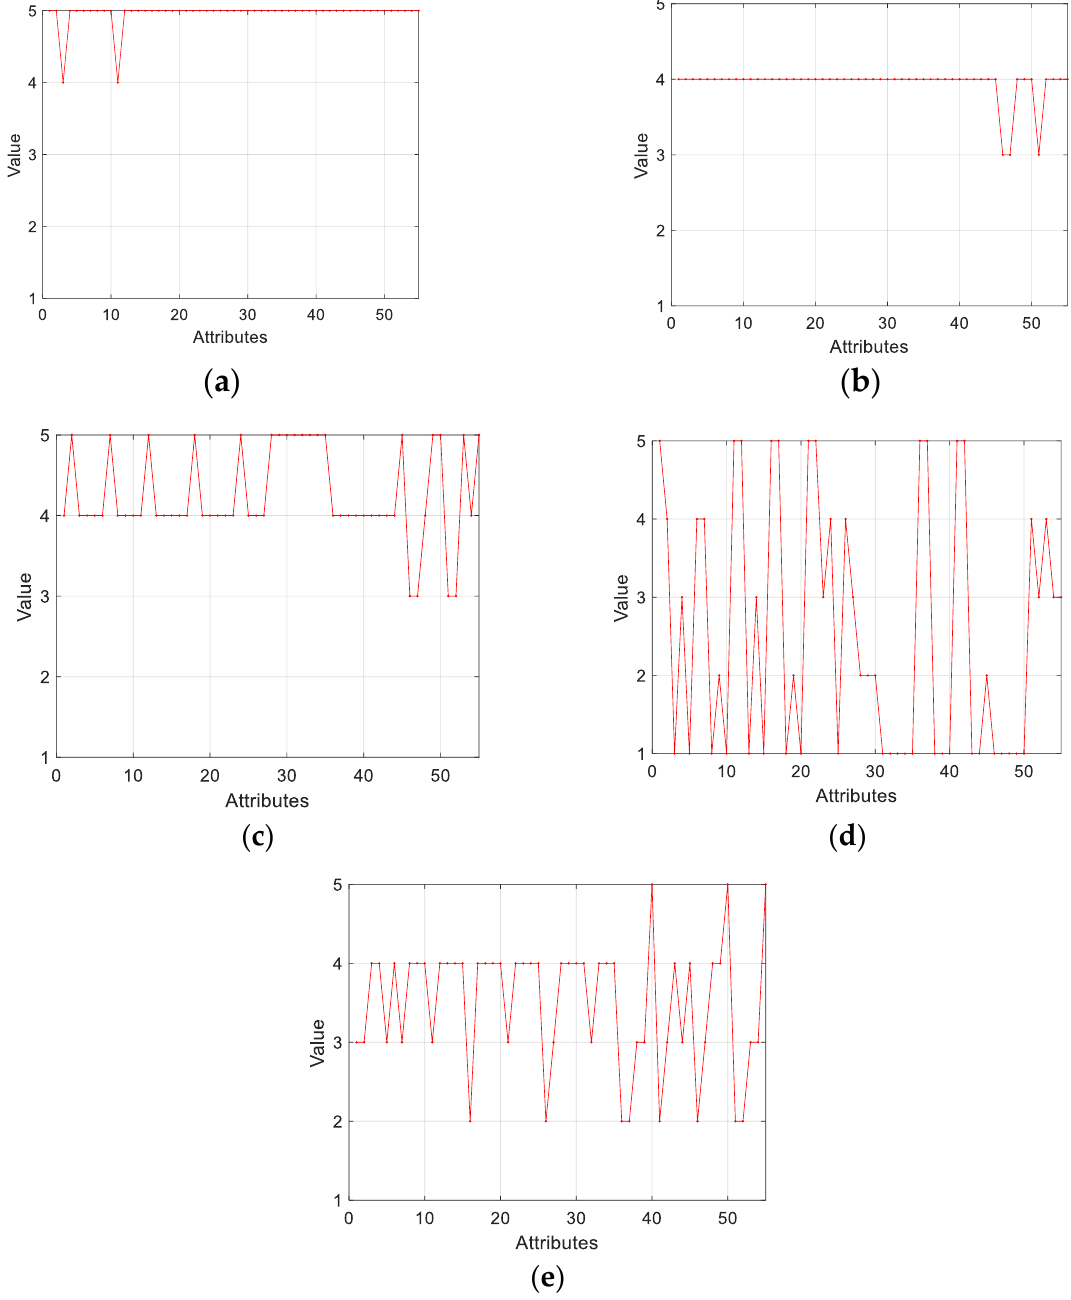
Figure 8. ( a ) Mental model A; ( b ) mental model B; ( c ) mental model C; ( d ) mental model D; ( e ) mental model E.